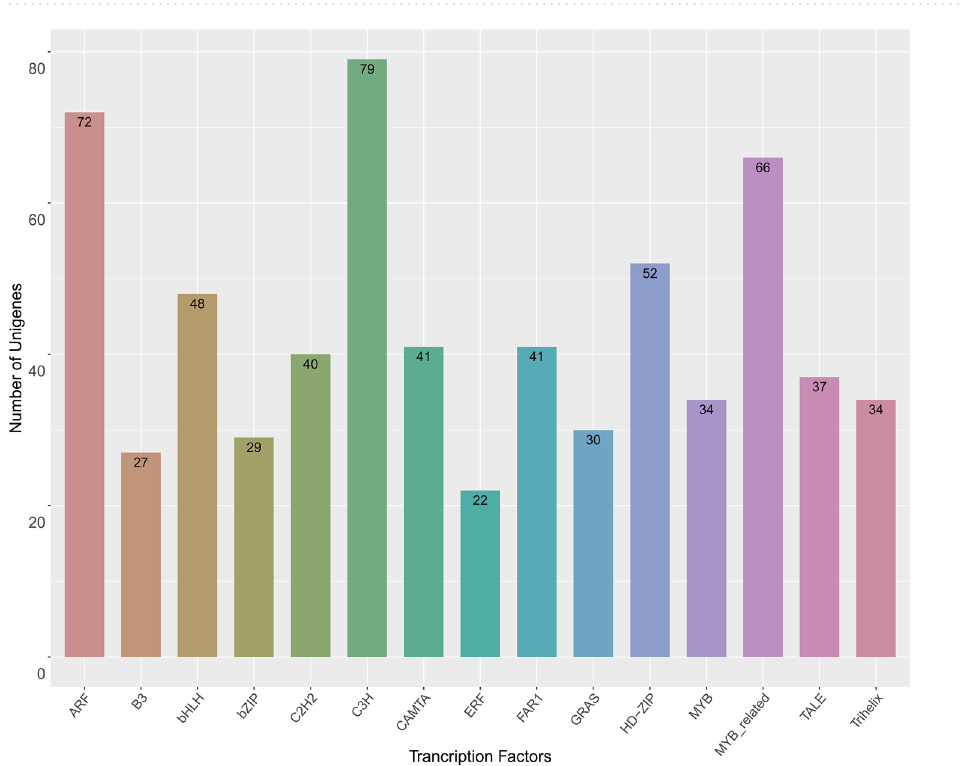
Figure 4. Transcription factors among the